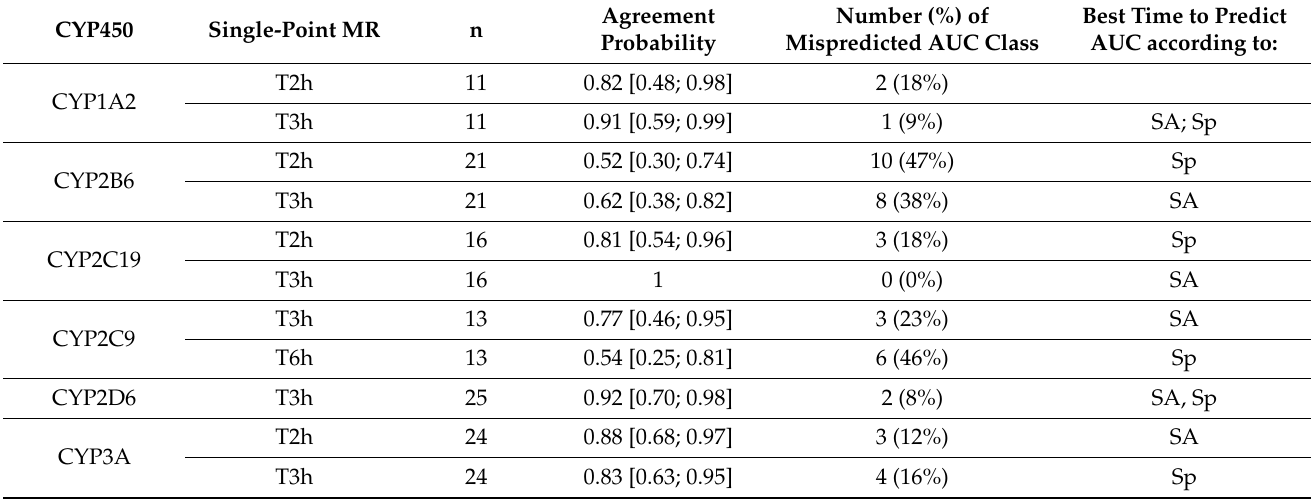
Table 4. Concordance table between the classification defined using AUC 0–6h MR and the classifica- tion defined using single-point